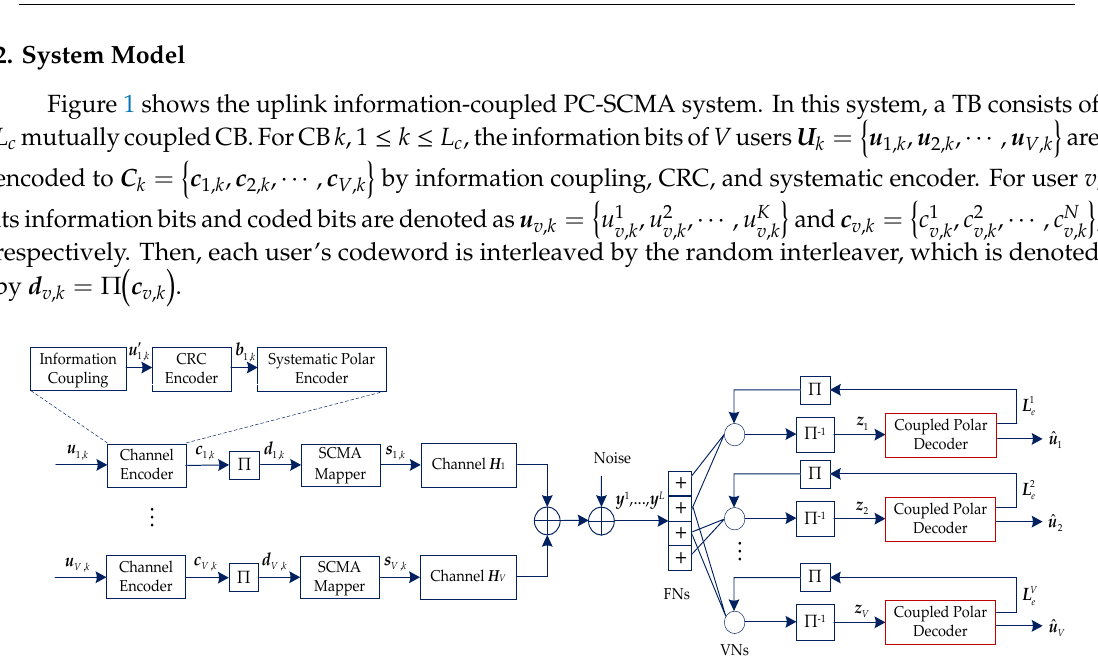
Table 1. Summary of abbreviations.